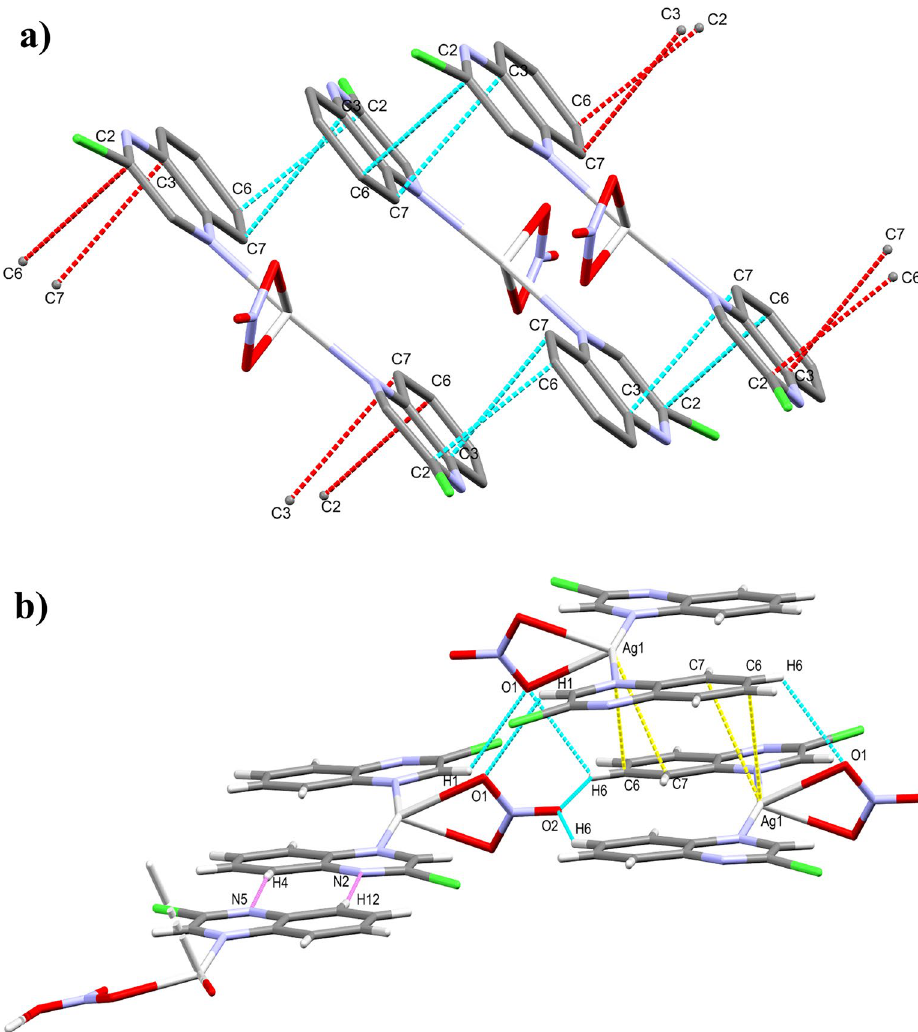
Figure 7. The π–π stacking interactions in complex 2a ( a ). The Crystal packing of 2 via O…H (light blue), Ag…C (yellow) and N…H (violet) interactions ( b ).